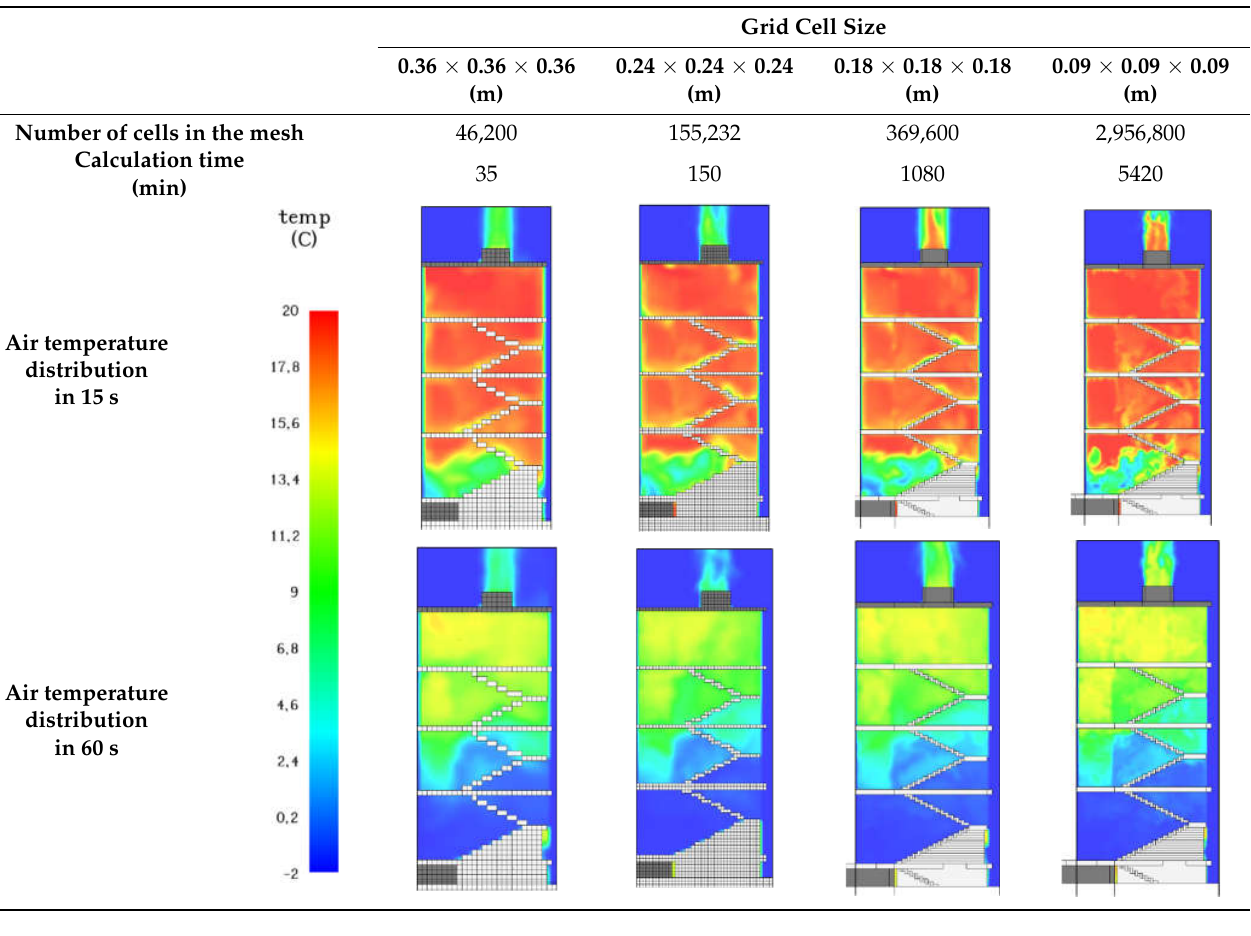
Table 1. Mesh size analysis.